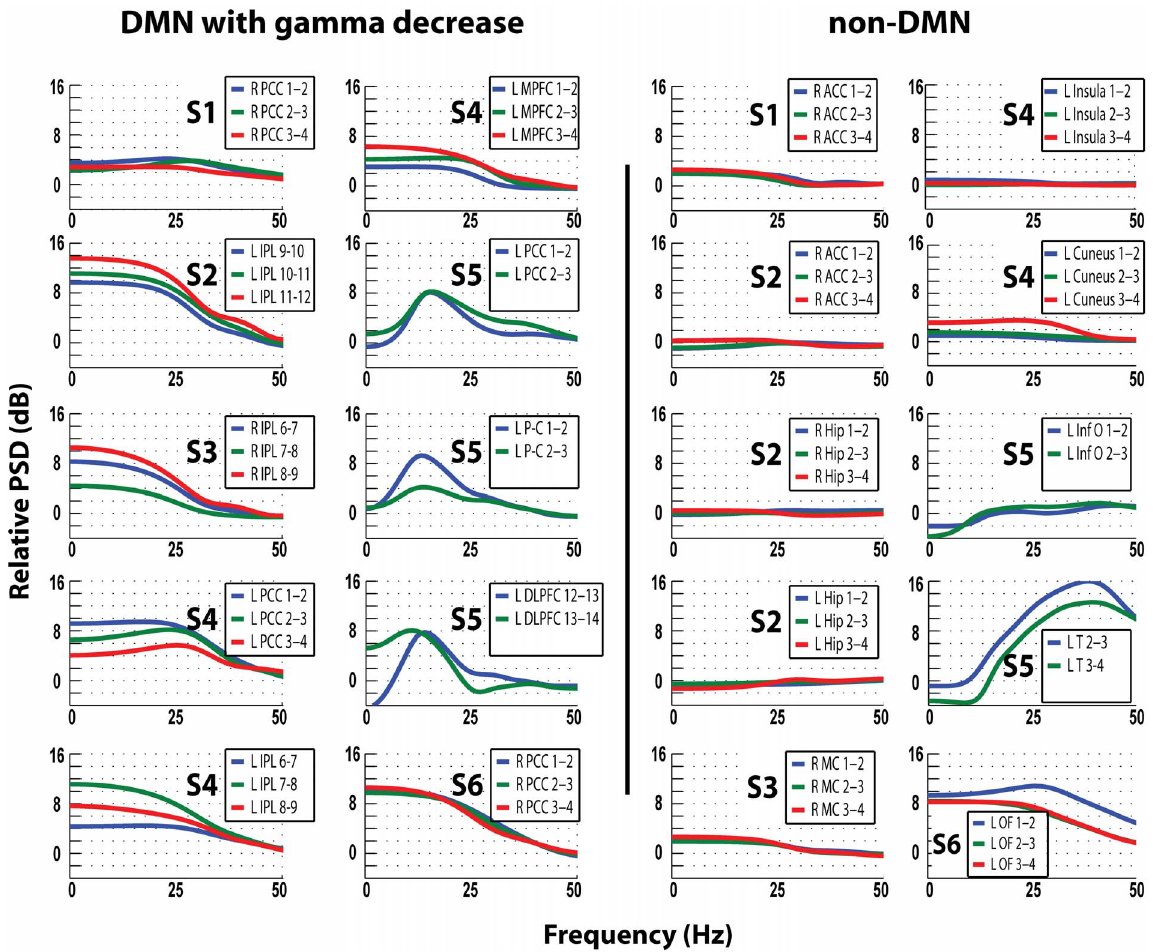
Figure 4. Relative power spectral density in dB, for frequencies 0–50 Hz. Power spectra in the DMN regions with gamma decrease and the non-DMN regions in all patients comparing 1 s epochs at the center of IED to baseline. Blue trace is the most medial, followed laterally by the green and red traces. S1–S6 relates to patients 1–6. Note the power increase in frequencies , 30 Hz in all DMN regions with gamma decrease, but only in 2/ 10 non-DMN locations: Temporal cortex in patient 5 shows increase in low frequencies, secondary to propagation of epileptic activity (Fig. 1B), and LOF contacts of patient 6 also due to propagation of IEDs originating from left SMA (not shown). Comparing Fig. 4 and 5 shows an inverse relationship between the decrease in gamma and the increase in the lower frequencies in many DMN nodes: contacts that showed more gamma decrease also had more increase in lower frequencies: For examples, compare the responses in L PCC in patient 4 and L P-C in patient 5. doi:10.1371/journal.pone.0068038.g004 PLOS ONE |